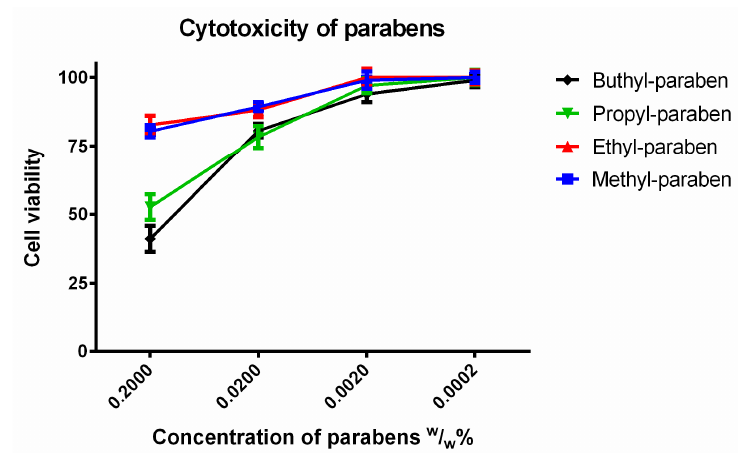
Figure 3. Cytotoxicity of parabens on Caco-2 cells measured by MTT-assay. Cell viability was expressed